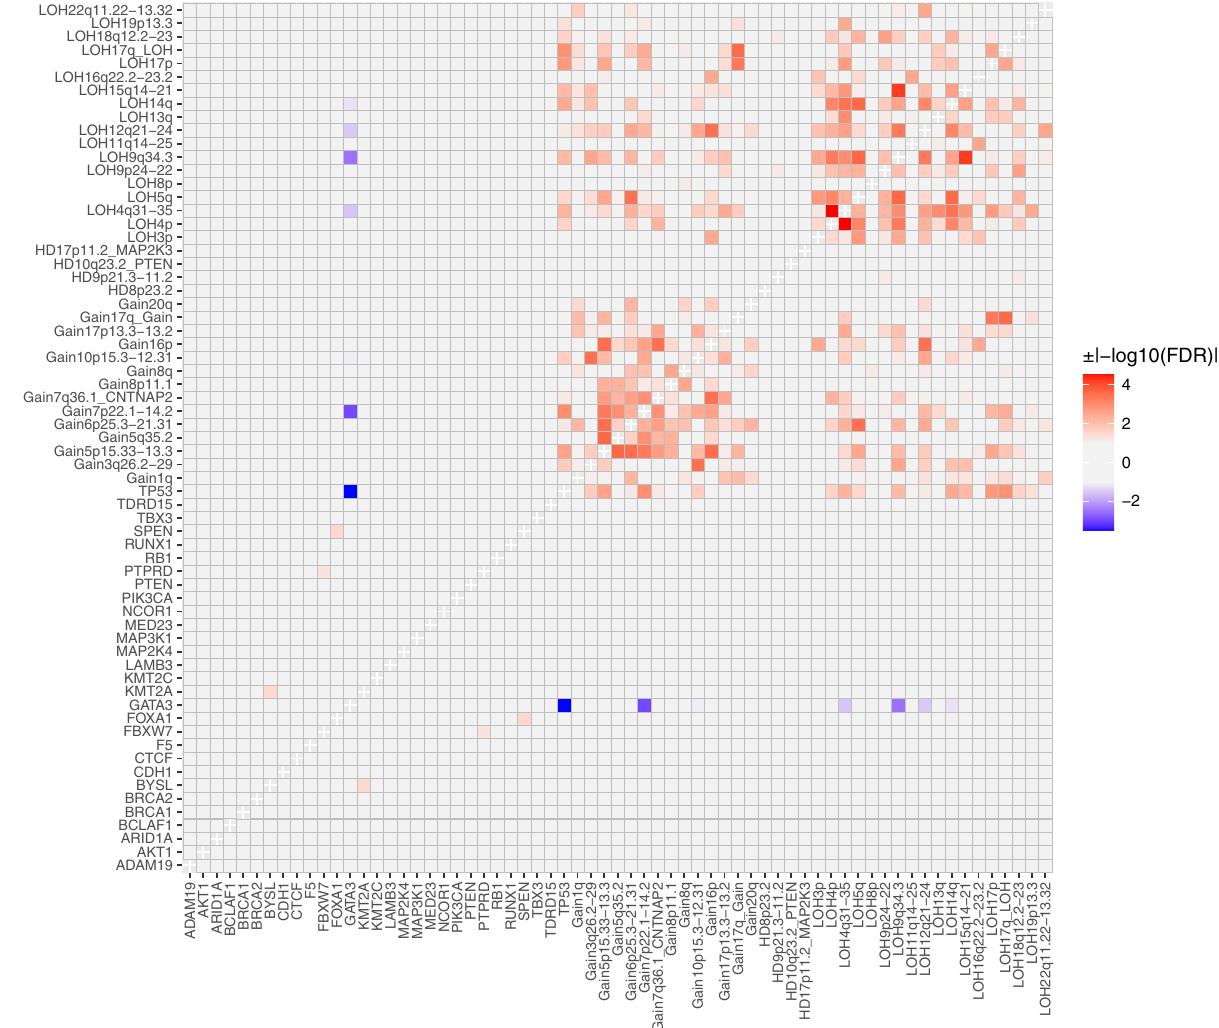
Fig. 7 Somatic interaction analysis in breast cancer tumors. Pairwise associations within and between mutational drivers and signi fi cantly enriched copy number aberrations were assessed using pairwise Fisher ’ s exact test. Signi fi cant associations (two-sided P-values adjusted for multiple testing, FDR < 0.05) are shown with positive associations (co-occurrence; OR > 1) having a positive sign (red) and negative associations (mutual exclusivity; 0 < OR < 1) having a negative sign